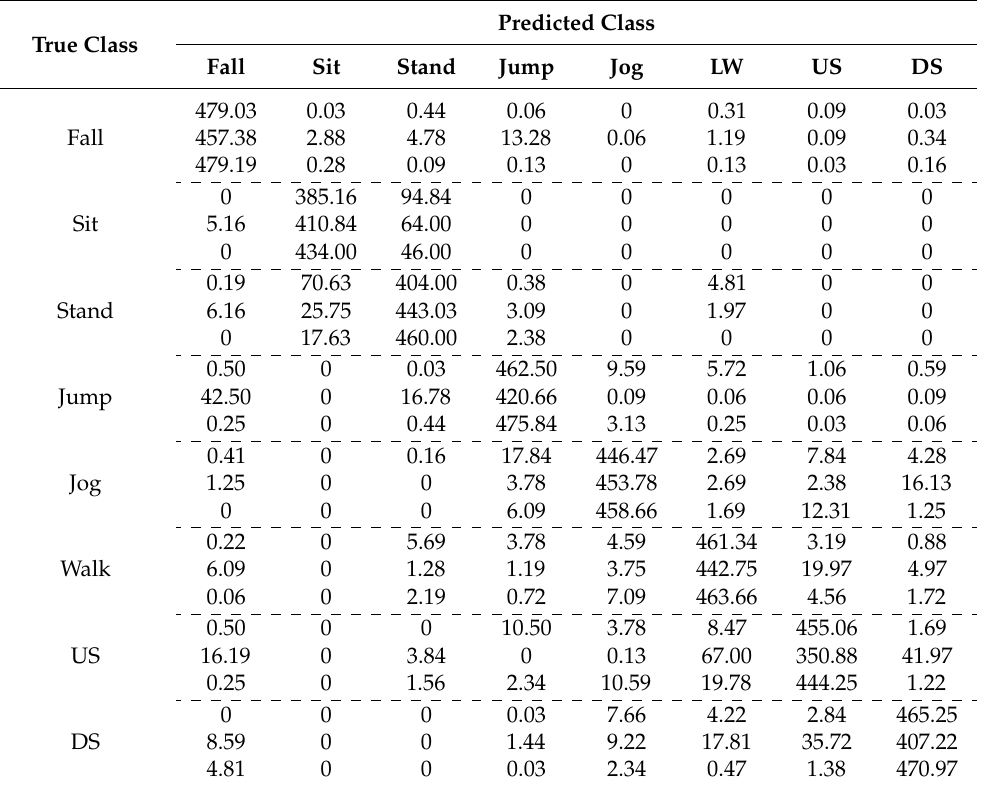
Table 8. Confusion matrix of the detections of fall and physical activities based on data from both